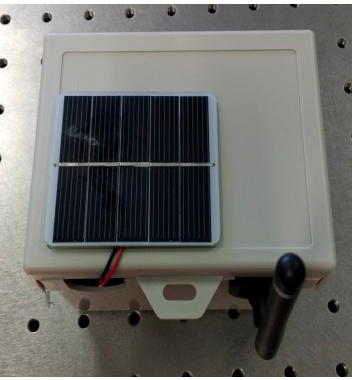
Figure 1. Schematic diagram of the self-powered environmental monitoring sensor node.